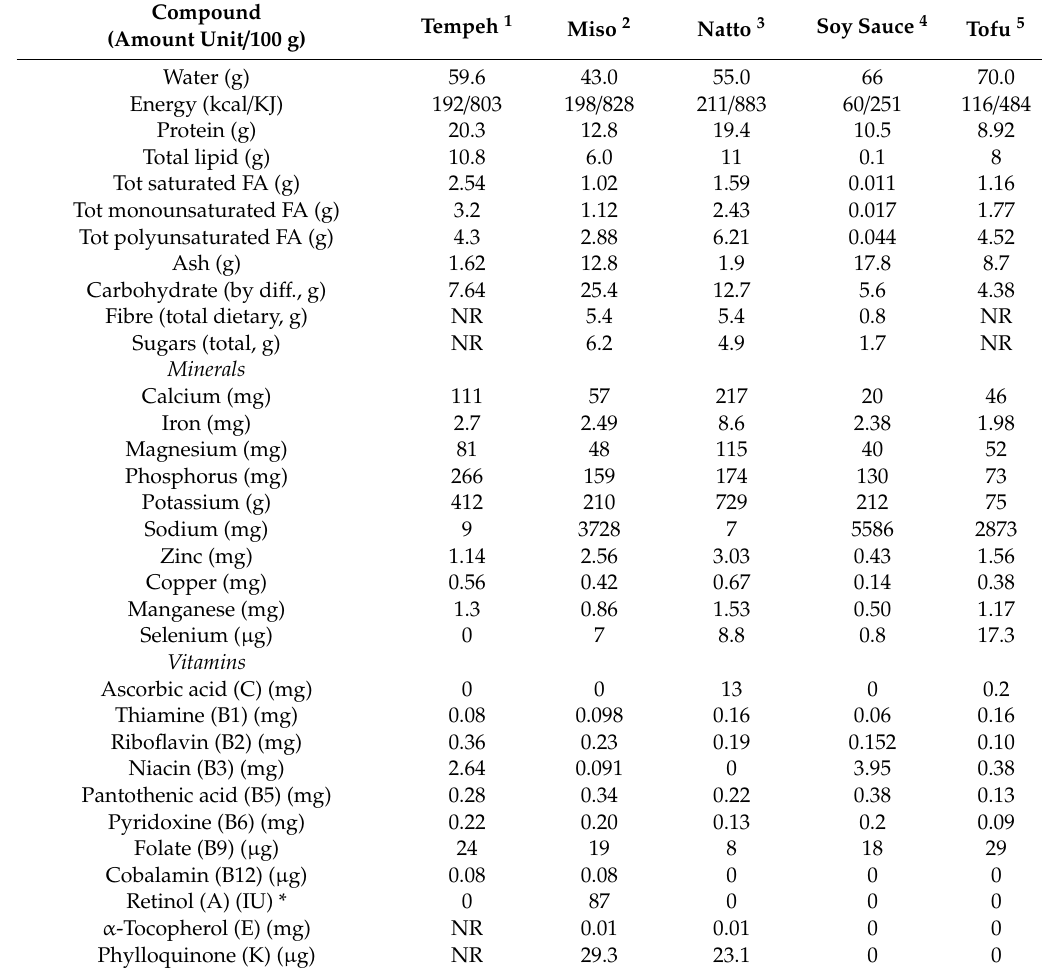
Table 2. Nutritional composition of traditional fermented soy-based foods, such as tempeh, miso, soy sauces, natto and tofu (100 g portion, based on USDA Nutrient Database)